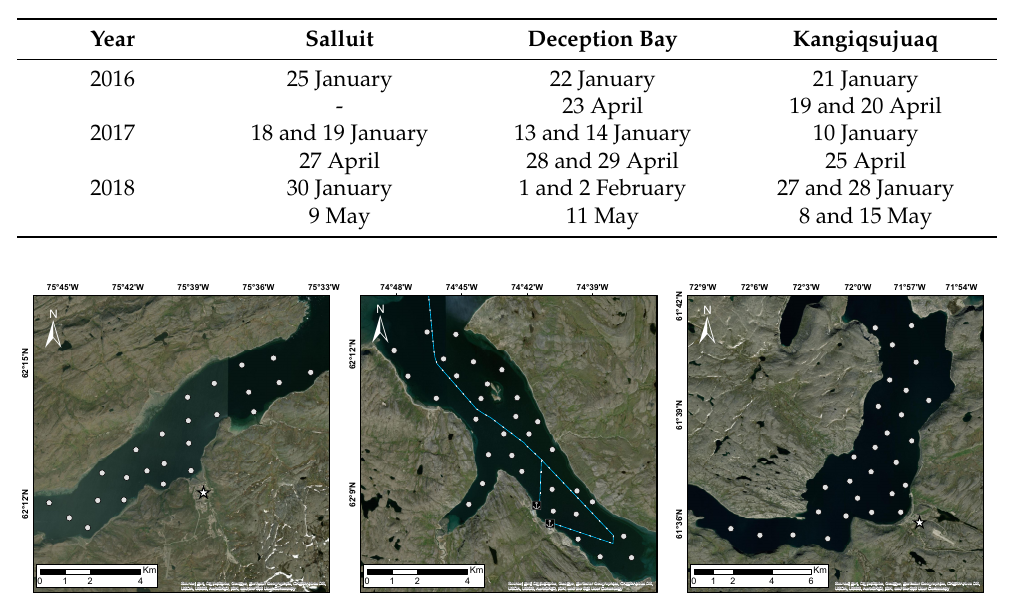
Figure 2. January 2018 sampling locations for Salluit, Deception Bay, and Kangiqsujuaq. Also shown for Deception Bay: the ship track (blue) and wharves (anchor markers). For Salluit and Kangiqsujuaq, community location is indicated with a white